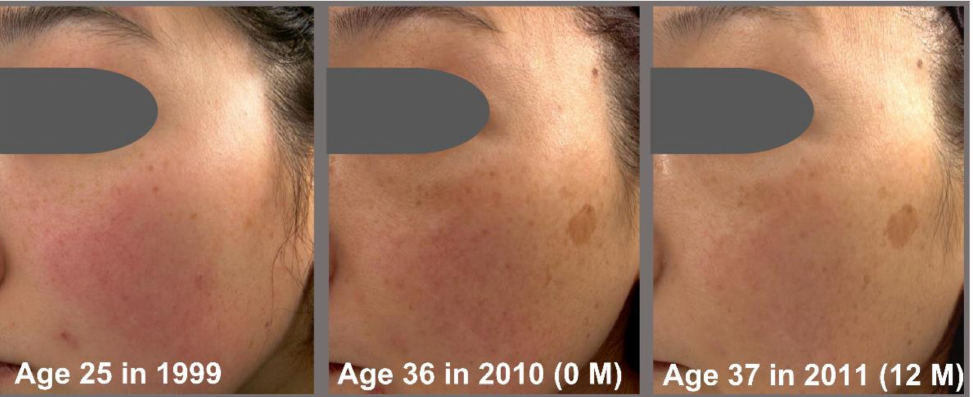
Figure 8. Chronological facial images of Case 3 (age: 25 in 1999). Twice-daily application of G3 products was performed from 2010 (0 M) to 2010 (12 M). Visual facial appearance aged from 1999